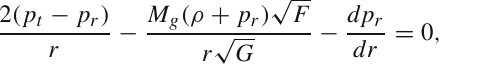
Fig. 2 Plot of the anisotropy parameter (19), anisotropic force F a = 2 Δ/ r . We note that the Rastall parameter has no contribution in the anisotropy, therefore GR and RT predicts same anisotropy in the case